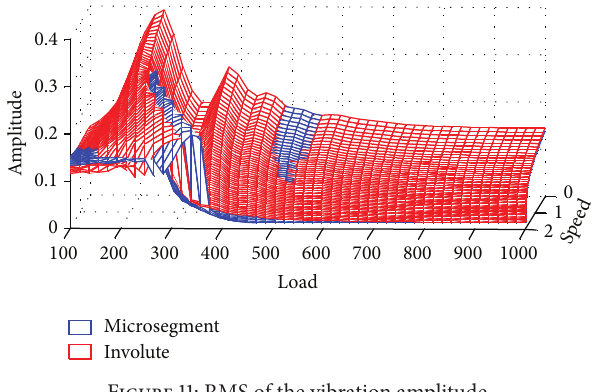
Figure 11: RMS of the vibration